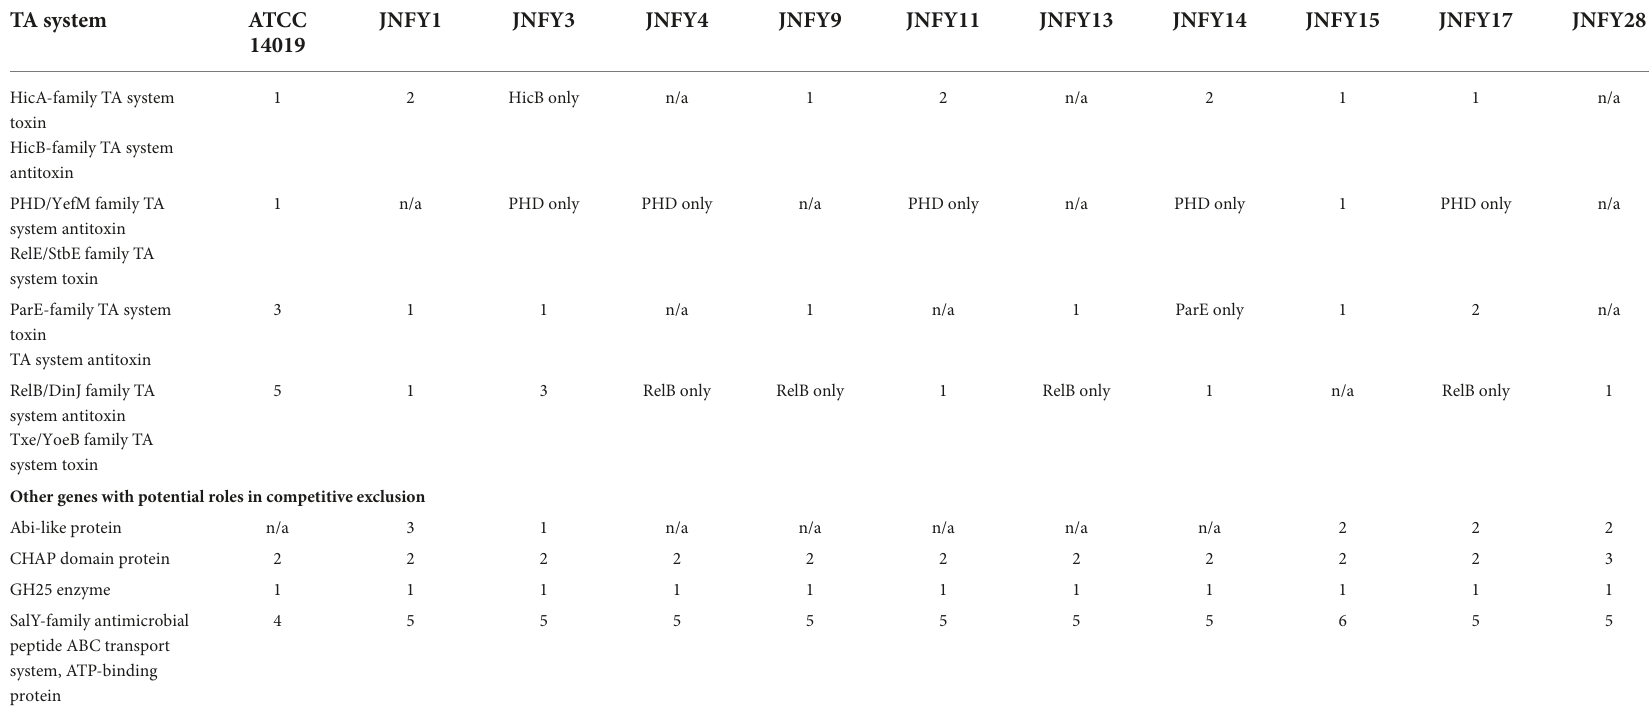
TABLE 5 TA system components and other competitive exclusion